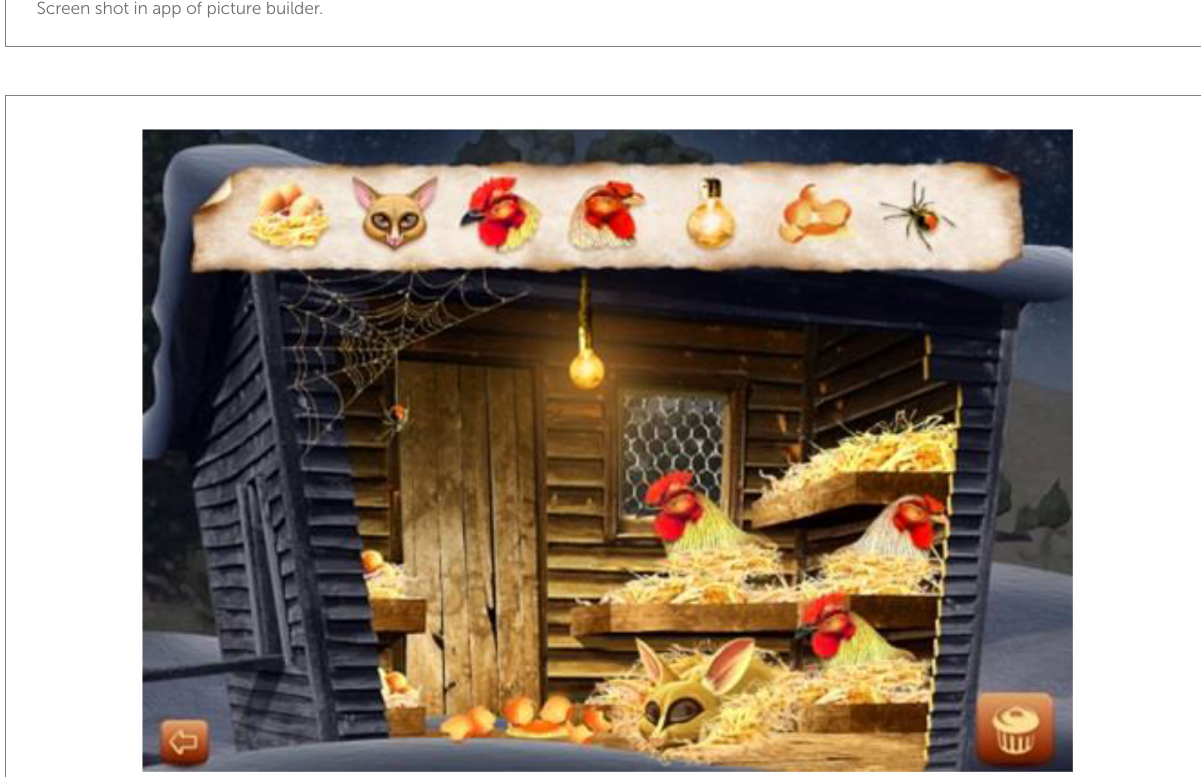
FIGURE 9 Screen shot in app of picture builder completed by